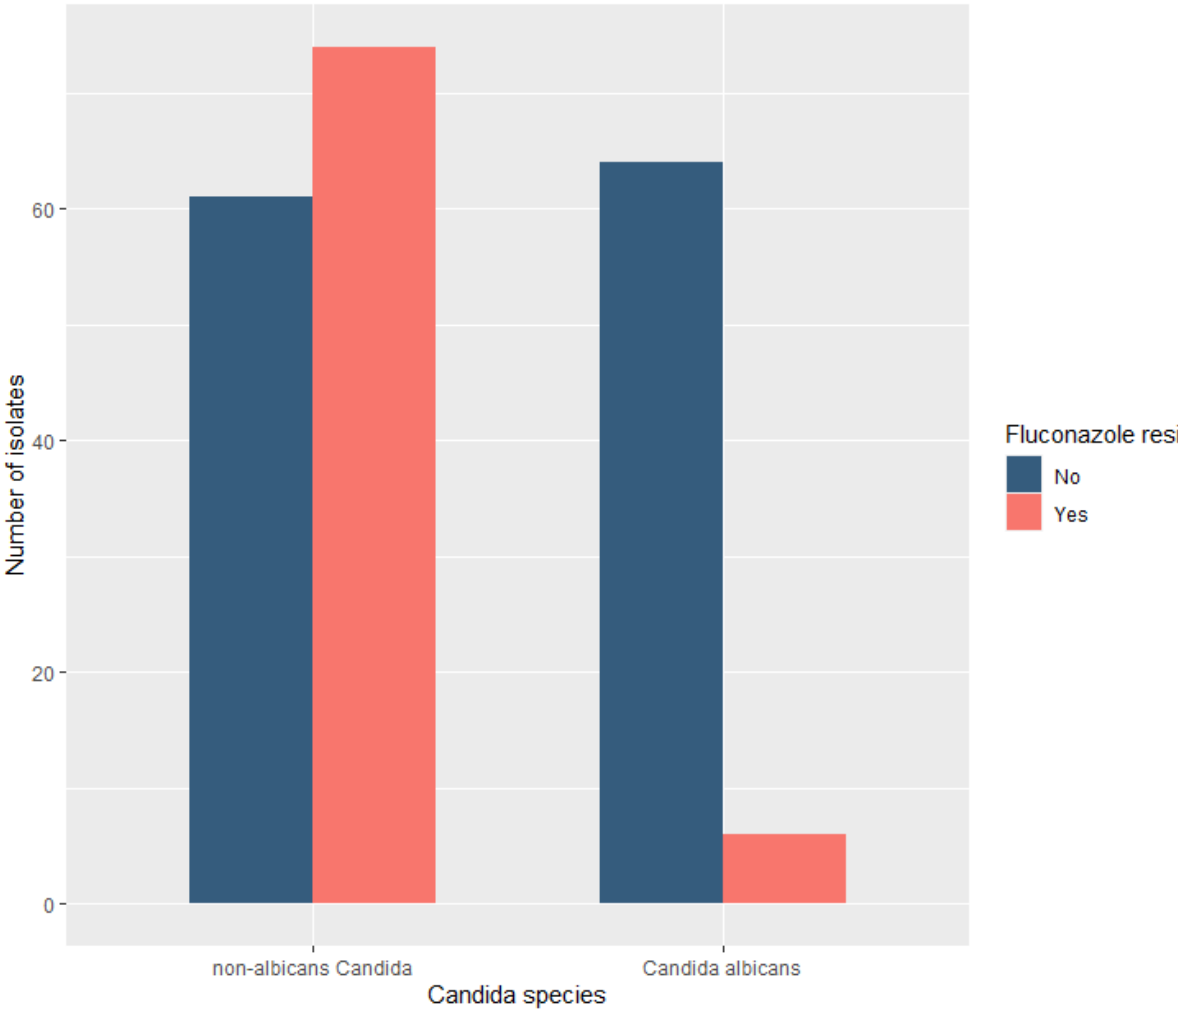
Figure 2. Fluconazole resistance in all ( n = 205) bloodstream-isolated Candida albicans and non- albicans Candida species. Table 4. Factors associated with candidemia development due to fluconazole-resistant Candida spe- cies in the overall patient population: univariate and multivariate models. OR (95% CI) takes flu- conazole-susceptible as the reference group.